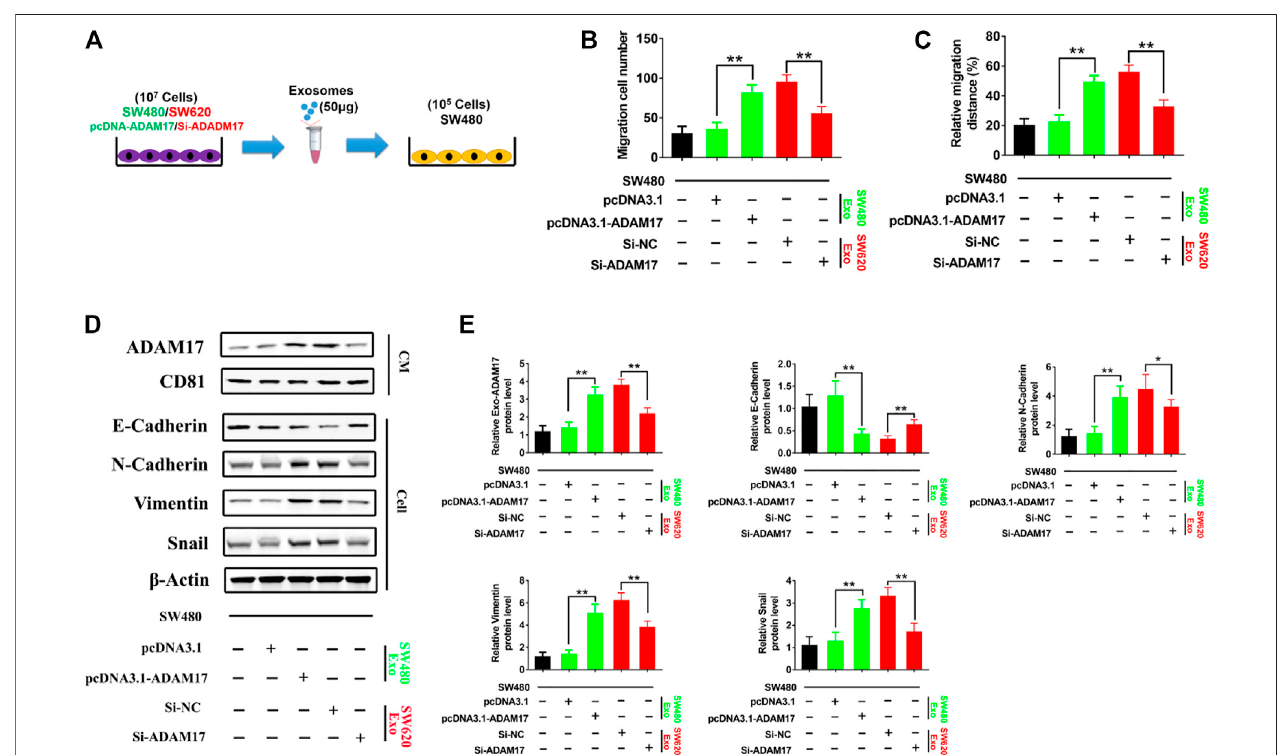
FIGURE 3 | Exosomal ADAM17 enhances the cleavage of E-cadherin. (A) Schematic description of the experimental design. The pcDNA3.1-, pcDNA3.1- ADAM17-transfected SW480-derived exosomes and Si-NC-, Si-ADAM17-transfected SW620-derived exosomes were isolated. 50 μ g of exosomes were added to 5 × 10 5 SW480 cells. (B,C) Changes in migration were measured via transwell and wound scratch assays using SW480 treated with pcDNA3.1-, pcDNA3.1-ADAM17- transfected SW480-derived exosomes as well as Si-NC-, Si-ADAM17-transfected SW620-derived exosomes ( n (cid:2) 6). (D,E) SW480 cells were treated with pcDNA3.1-, pcDNA3.1-ADAM17-transfected SW480-derived exosomes and Si-NC-, Si-ADAM17-transfected SW620-derived exosomes. Exosomes and lysed cells were collected for the assessment of protein levels via gray analysis (the total exosomal protein was set as the internal control for exosomal protein analysis, ß -actin was set as the internal control for cells, n (cid:2) 6). Data are expressed as means ± SDs. *, p < 0.05; **, p <